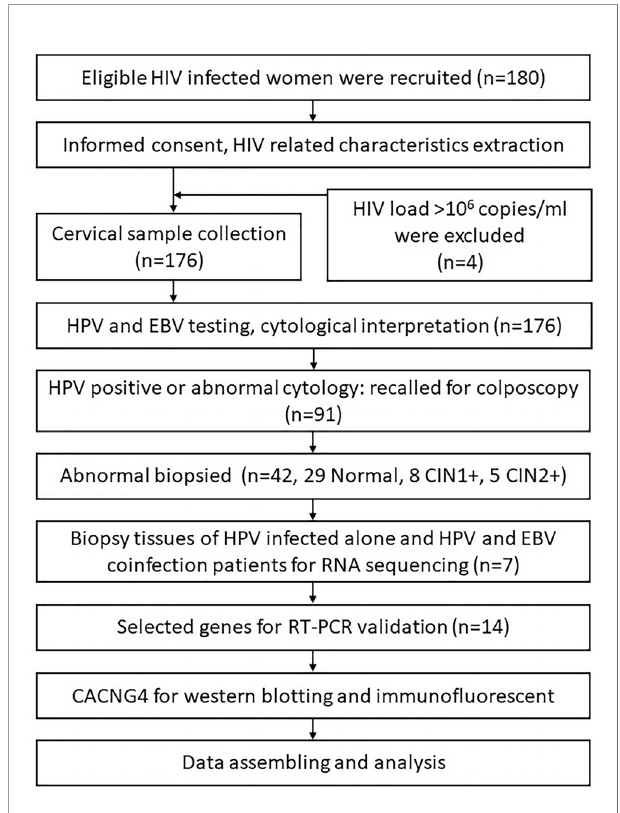
FIGURE 1 | A summary of the study